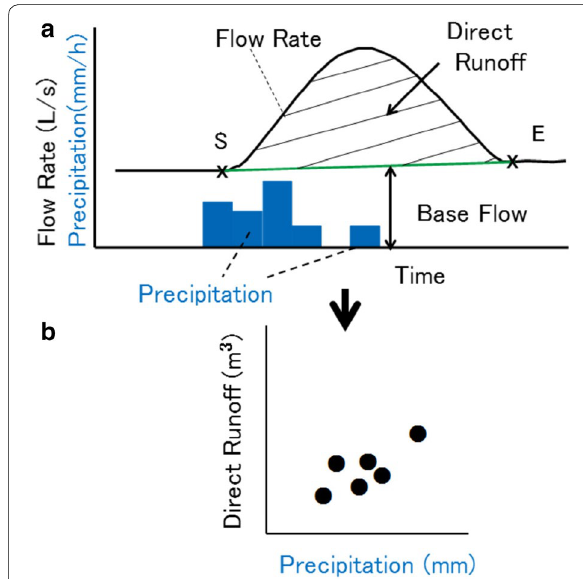
Fig. 3 Schematic hydrograph showing the separation of baseflow and direct runoff. a Separation of baseflow and direct runoff. All precipitation between the start (S) and end (E) points is added to one precipitation series that causes direct runoff. b Correlation between direct runoff and